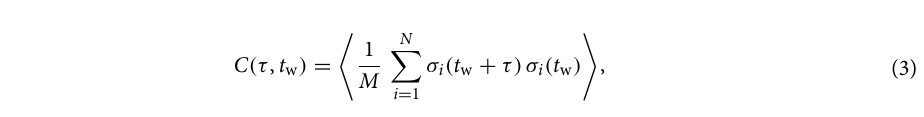
Figure 4. Coarsening towards the segregated state at two different values of T for both models. Snapshots are taken for 5, 500, 5000 and 50,000 time steps ordered from left to right. We set system size L ρ v 0.005 =